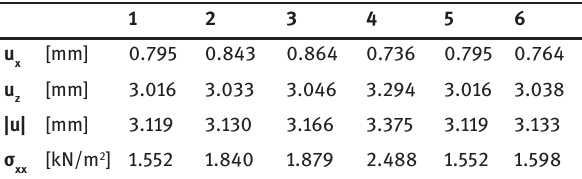
Table 7: Maximum values obtained for each combination.